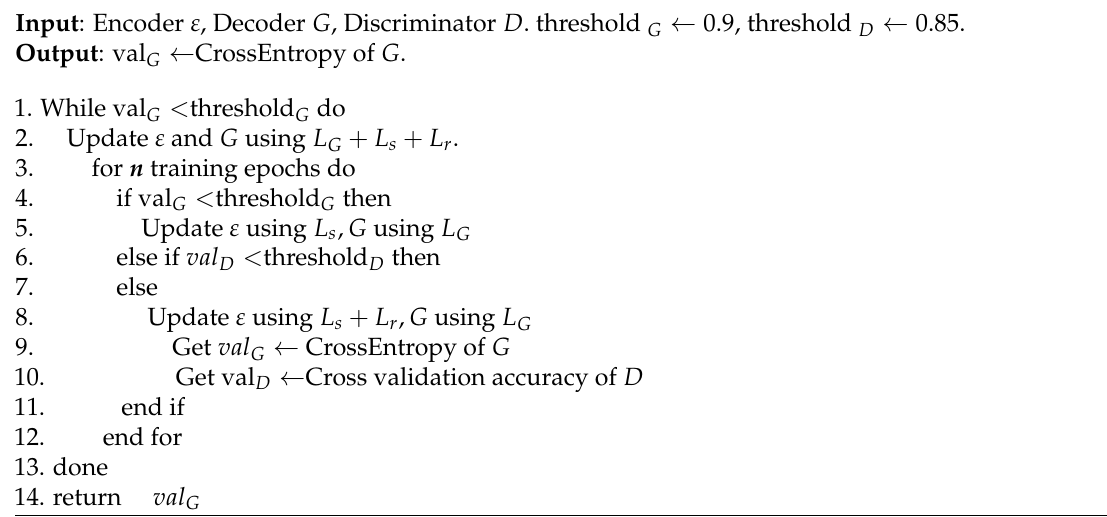
Algorithm 1 Steganographic training algorithm based on